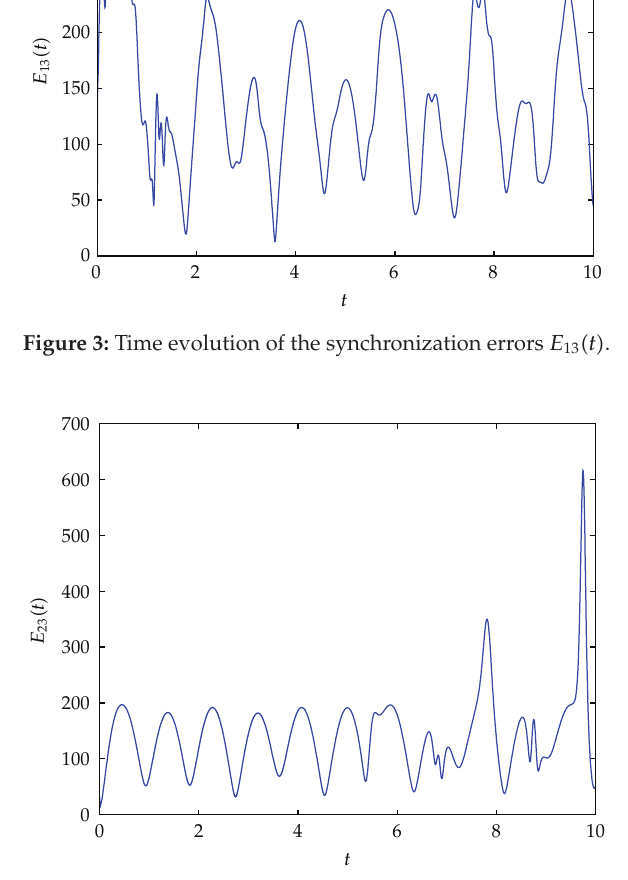
Figure 4: Time evolution of the synchronization errors E 23 (cid:6) t (cid:7)